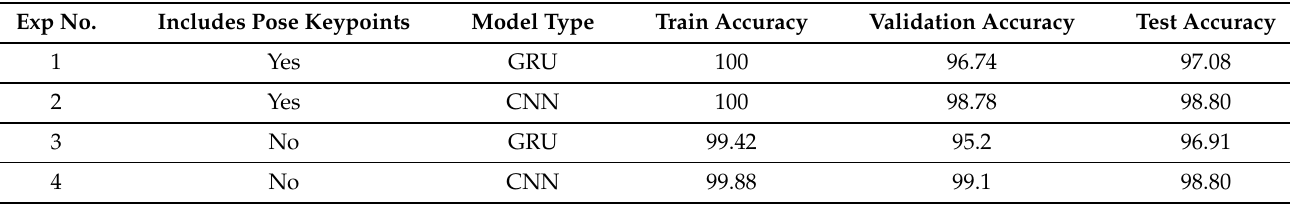
Table 5. Experiments results on the DSL-46